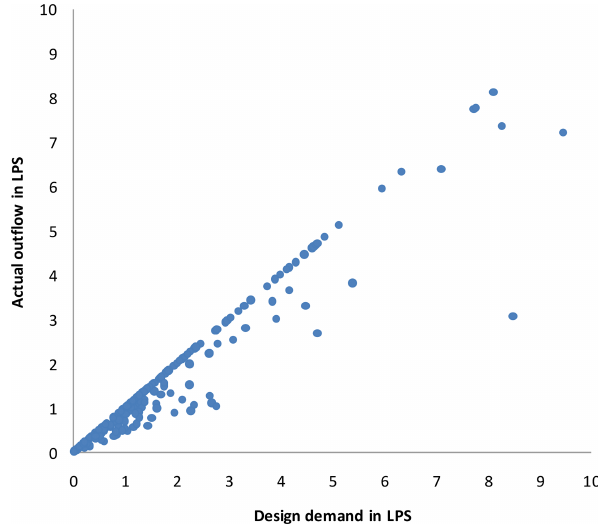
Figure 6. Actual outflow against design demand under no supply from reservoir ID 272 (LPS – liters per second).